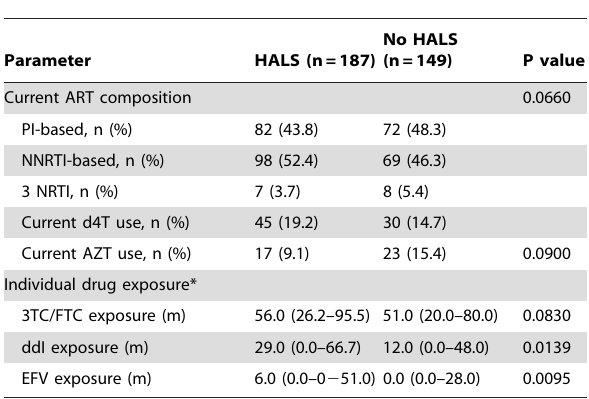
Table 2. Antiretroviral drug exposure in the population